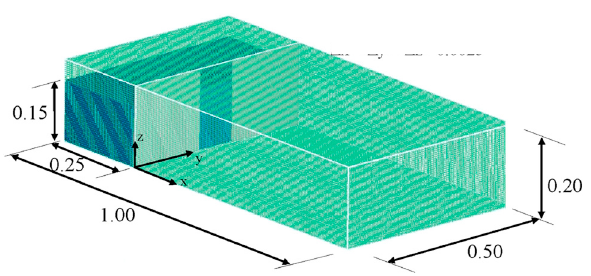
Figure 3. 3D configuration of the numerical model for the RANS simulations (dry case).